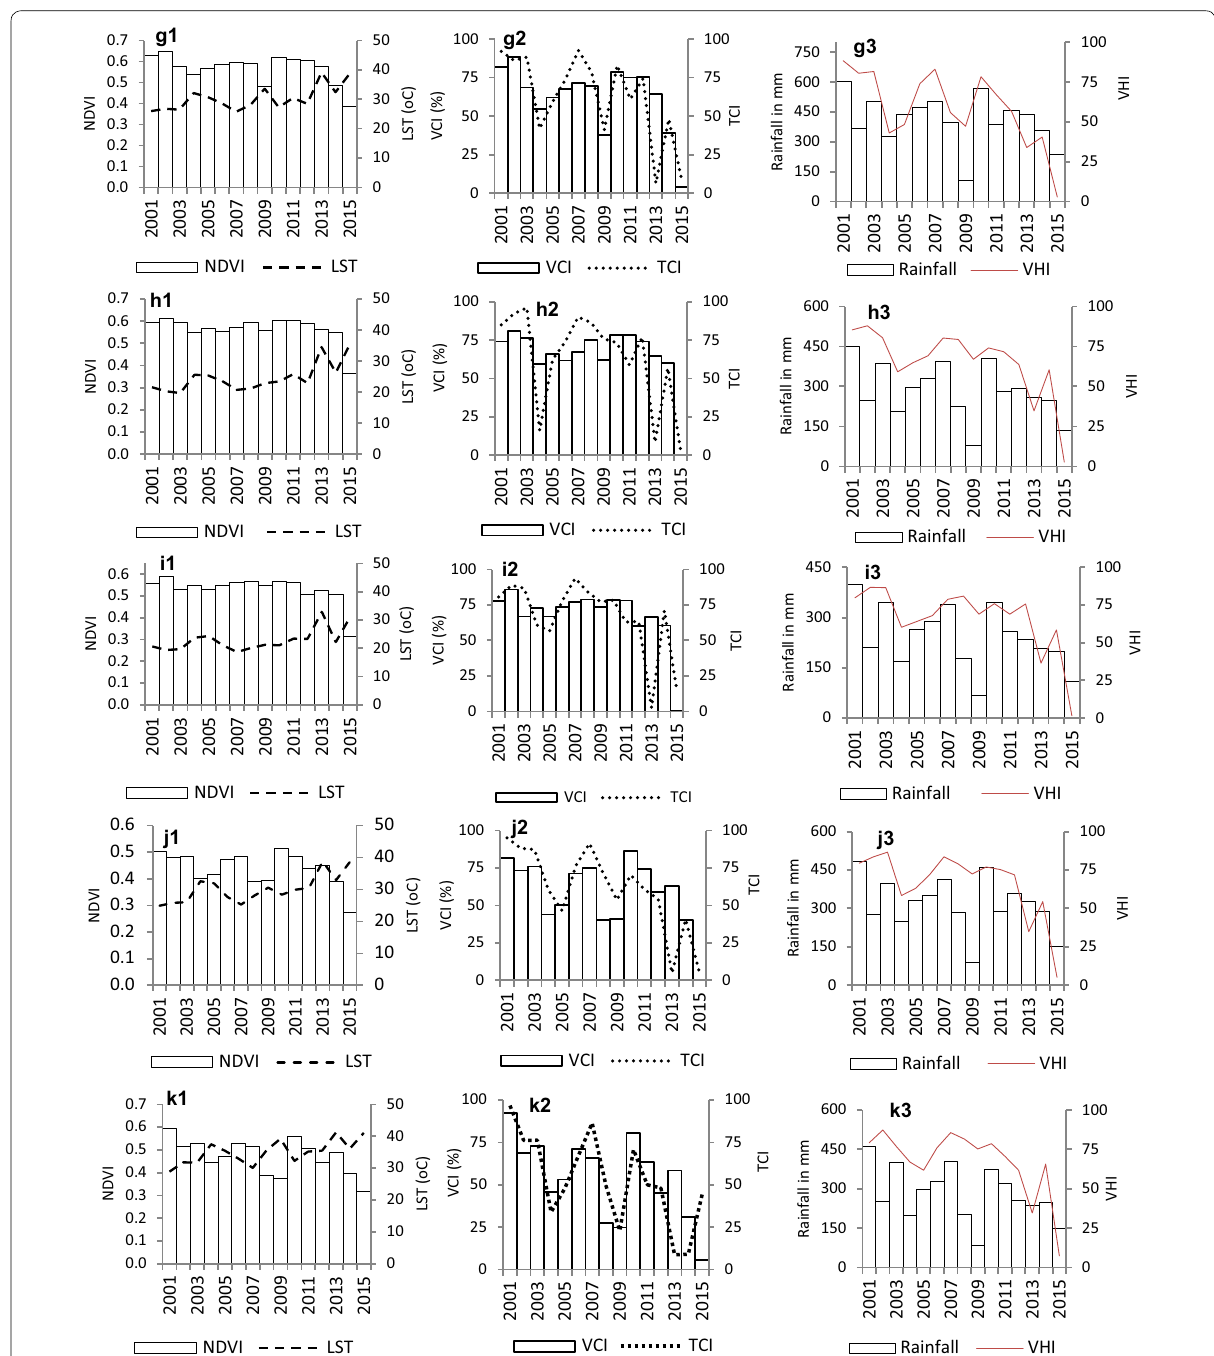
Fig. 4 Multi-temporal trend of LST-NDVI, VCI-TCI, and VHI—rainfall 2001–2015. Midlands area: g1 – g3 HintaloWejirat, Highlands area: h1 – h3 Endamehoni, i1 – i3 Ofla, j1 – j3 Alaje, k1 – k3